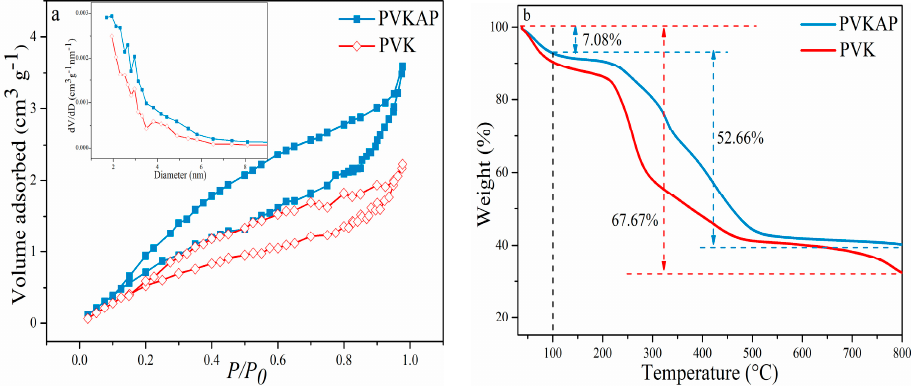
Figure 3. ( a ) Nitrogen adsorption–desorption isotherms of PVK and PVKAP; ( b ) the thermogravimetric analysis (TGA) analysis curves of PVK and PVKAP. Table 1. Pore structure parameters of PVK and PVKAP.